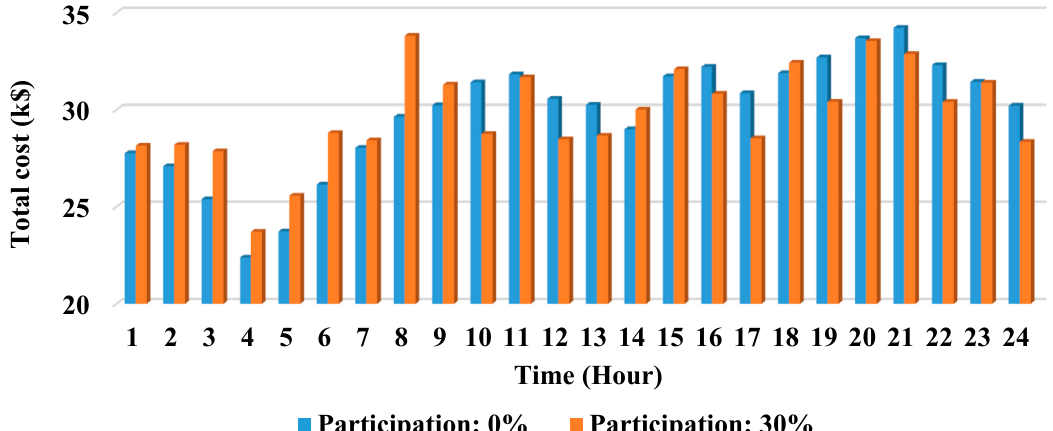
Figure 19. The system cost with and without demand response for a typical day in week 10.